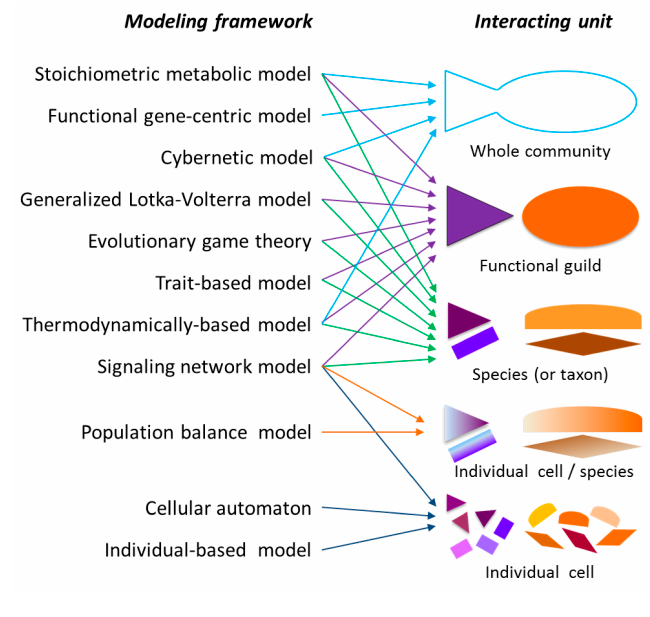
Figure 2. Classification of community models depending on interacting units. Individual shapes represent independent interacting units. Variance of state and functions across interacting units is represented by different colors. Color gradient in population balance model implies the heterogeneity in states and functions within the interacting unit. Representation of microbial communities using a fish shape is inspired by Scheffer et al.